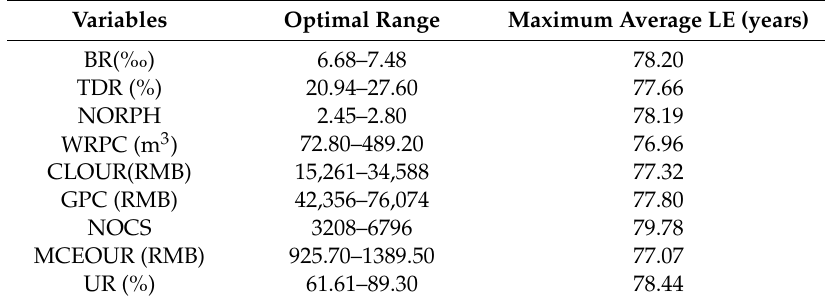
Table 6. The optimal range of social and environmental factors and maximum average LE.